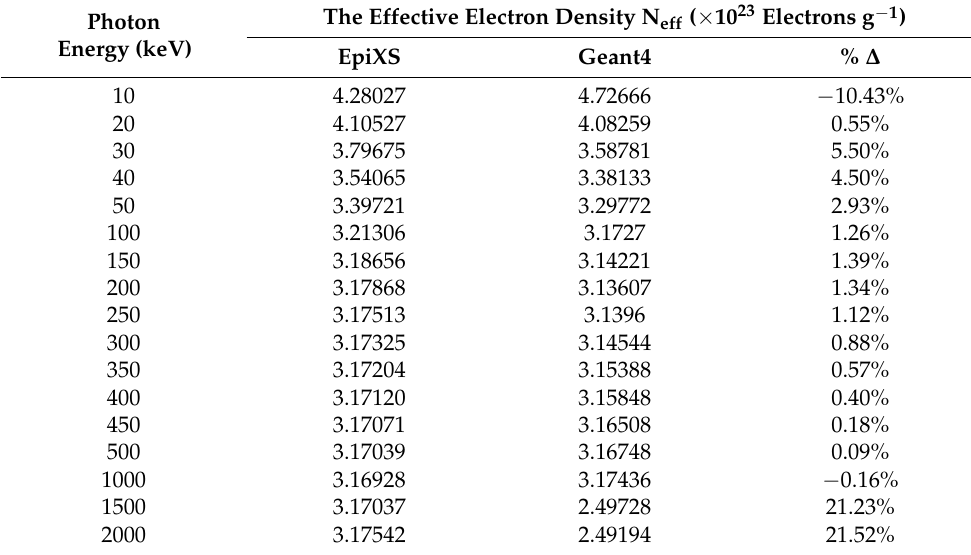
Table 3. The effective electron density of the investigated Polyimide was found by EpiXS and Geant4. Photon